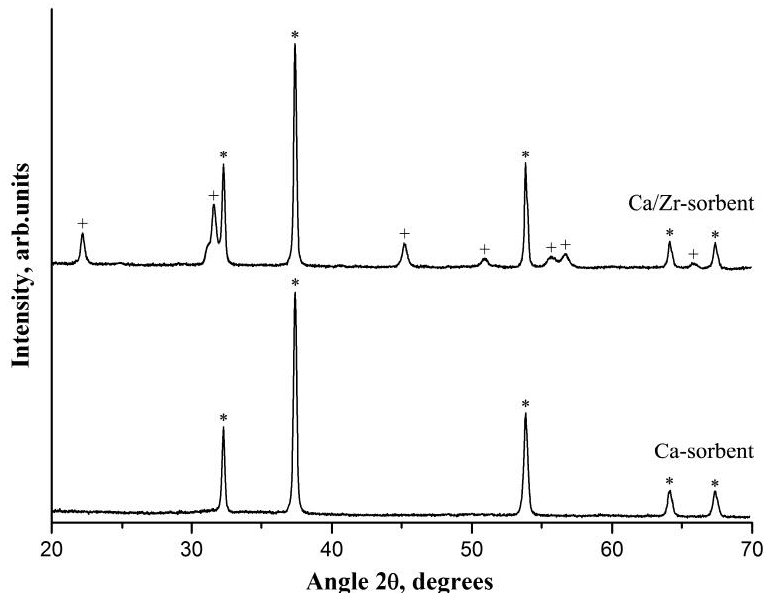
Figure 4. XRD patterns of the pure CaO sorbent and the Zr-doped CaO sorbent. The following compounds were identified: ( * ) – CaO; ( + ) – CaZrO 3 .